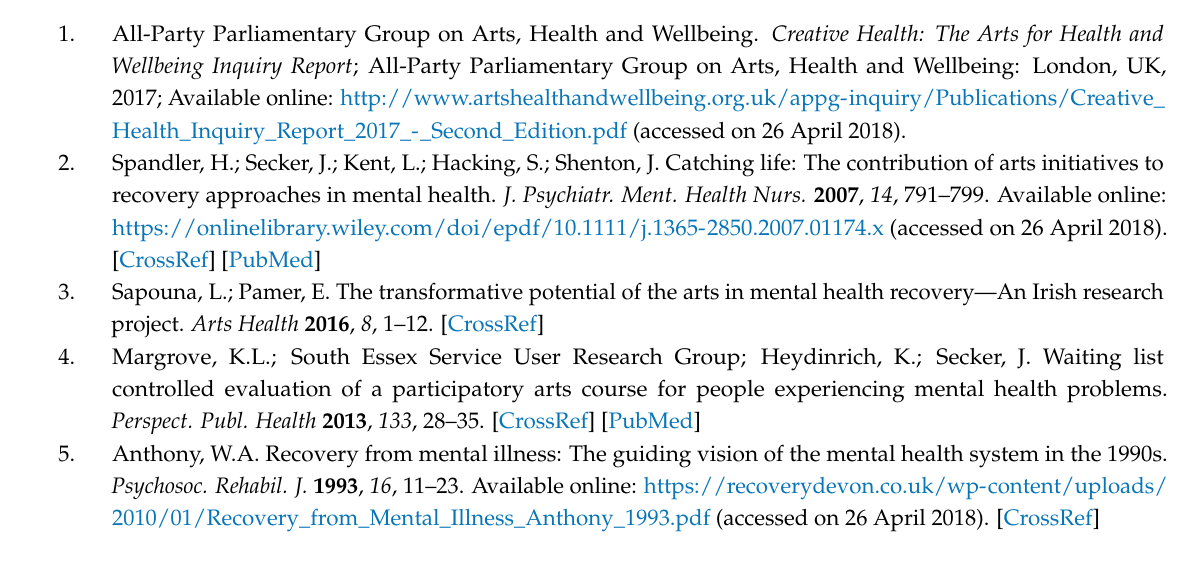
s1, Figure S1: Clinical Governance Certificate of Approval, Table S1: Scores on anonymous post course feedback forms, Table S2: Semi-structured interviews with service users at three month follow-up—October 2016, Table S3: Semi-structured interviews with service users at six month follow-up—January 2017, Table S4: Semi-structured interviews with service users at nine month follow-up—April